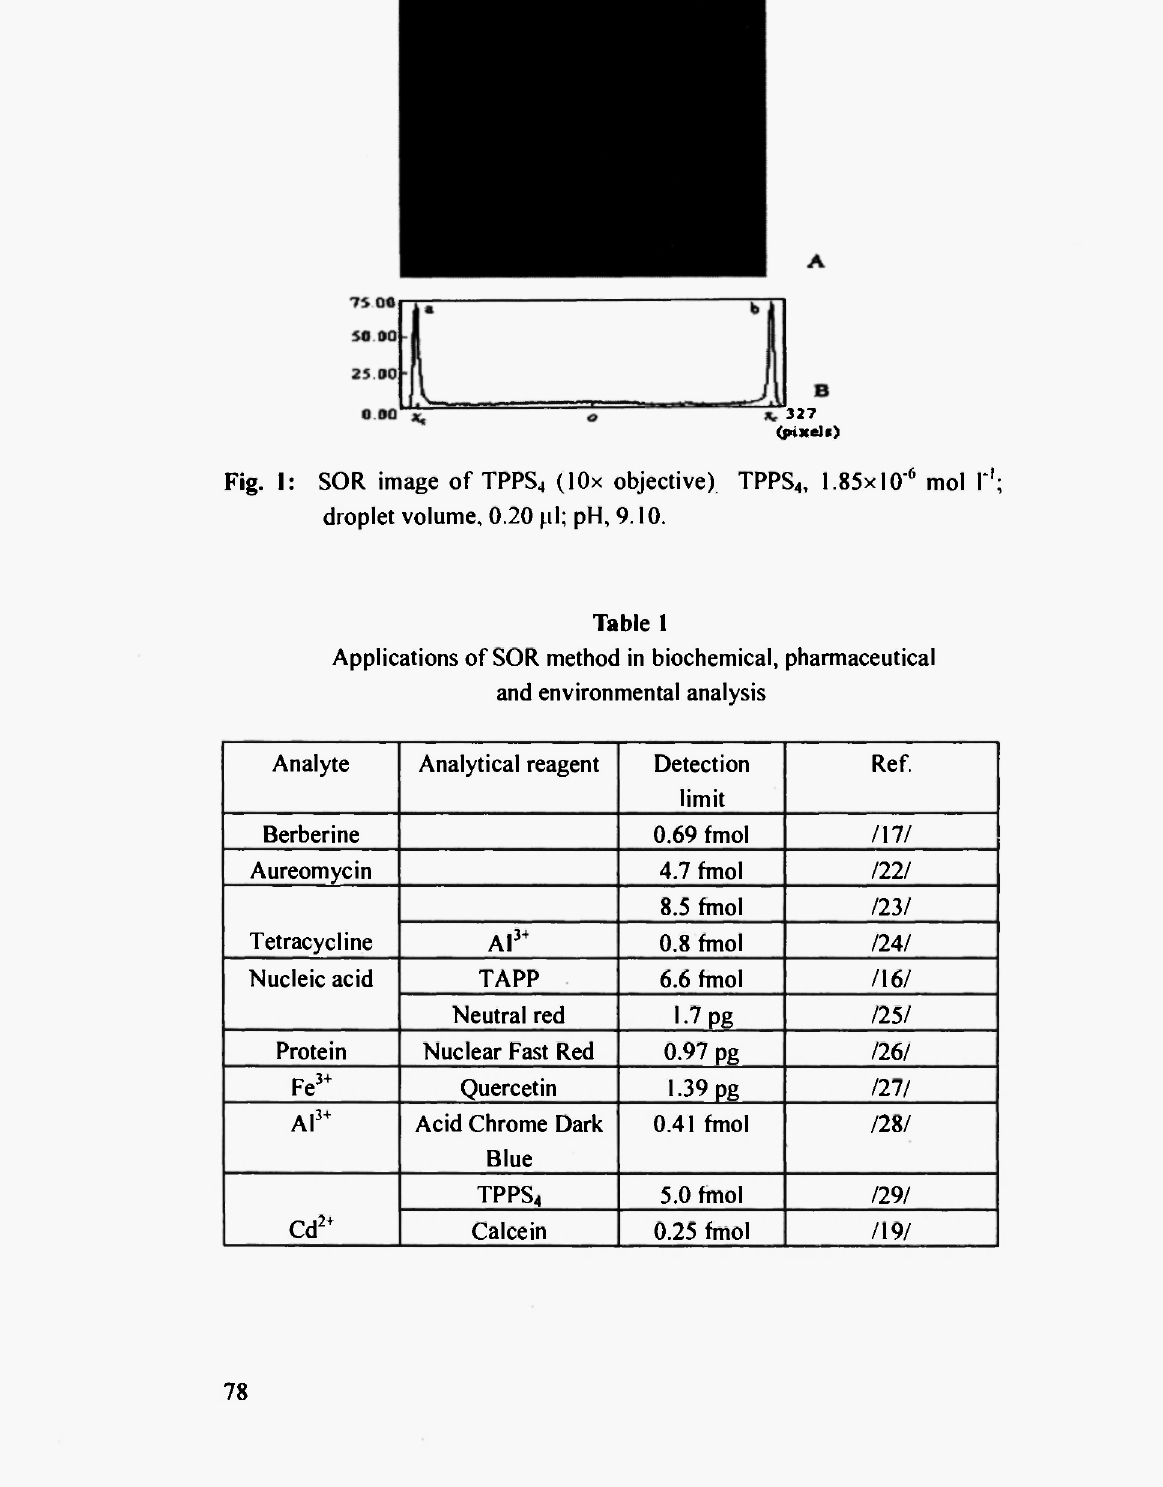
Fig. I: SOR image of TPPS 4 (ΙΟχ objective) TPPS 4 , 1.85xl0" 6 mol l" 1 ; droplet volume, 0.20 μΙ; pH, 9.10.